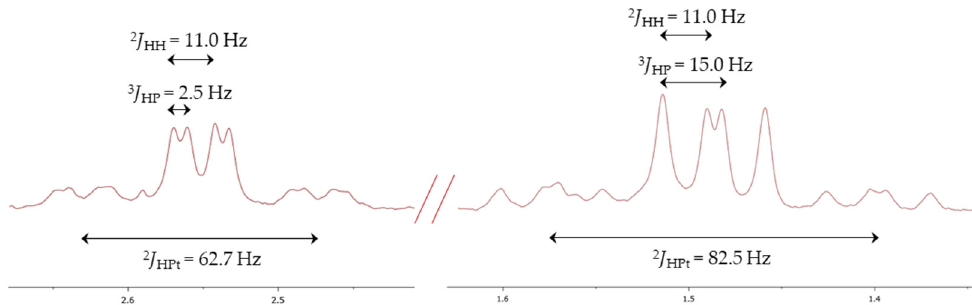
Figure 7. 1 H NMR signals of the AMX spin system due to the four Pt-CH 2 protons in 3 · CO (CD 2 Cl 2 ) with the corresponding 1 H- 1 H (A-M), 1 H- 31 P (A-X and M-X), and 1 H- 195 Pt couplings.